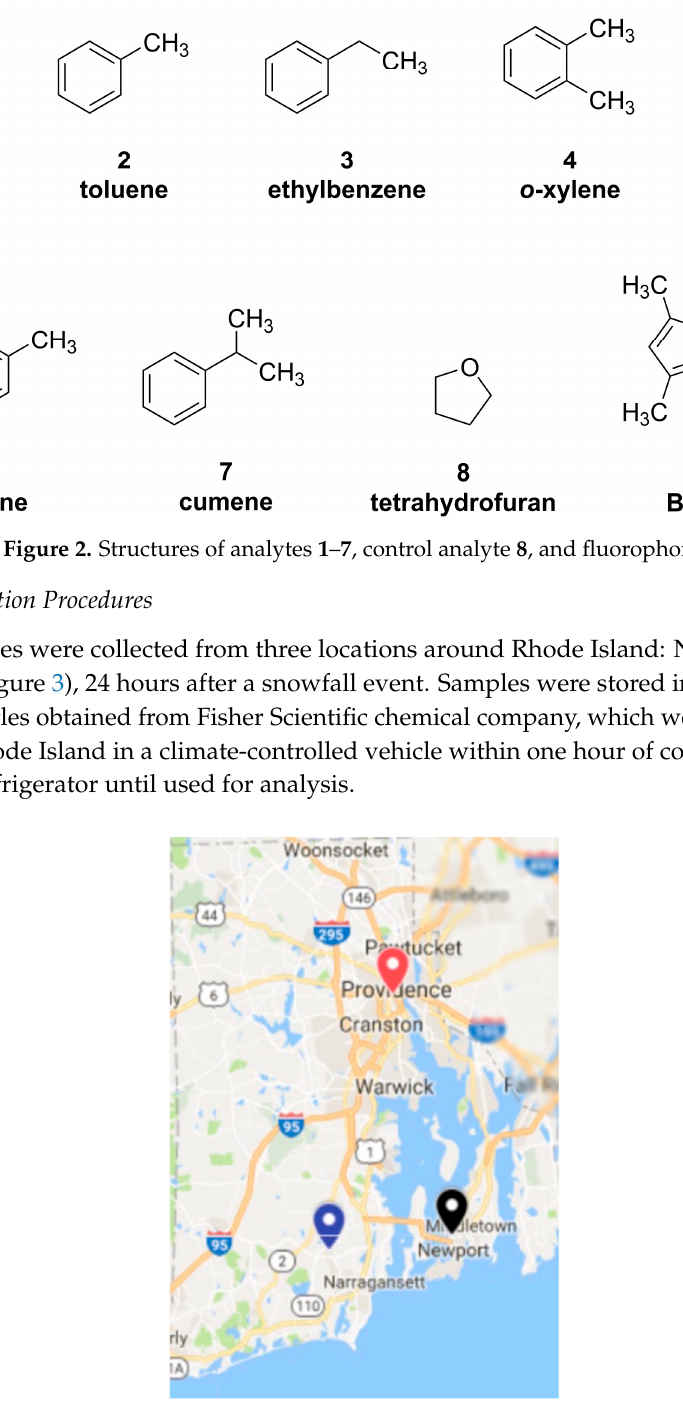
Figure 3. Map of snow sampling locations. The black marker represents Newport snow, the red marker represents Providence snow, and the blue marker represents Kingston snow. The map has been digitally manipulated so that only the state of Rhode Island is in focus.